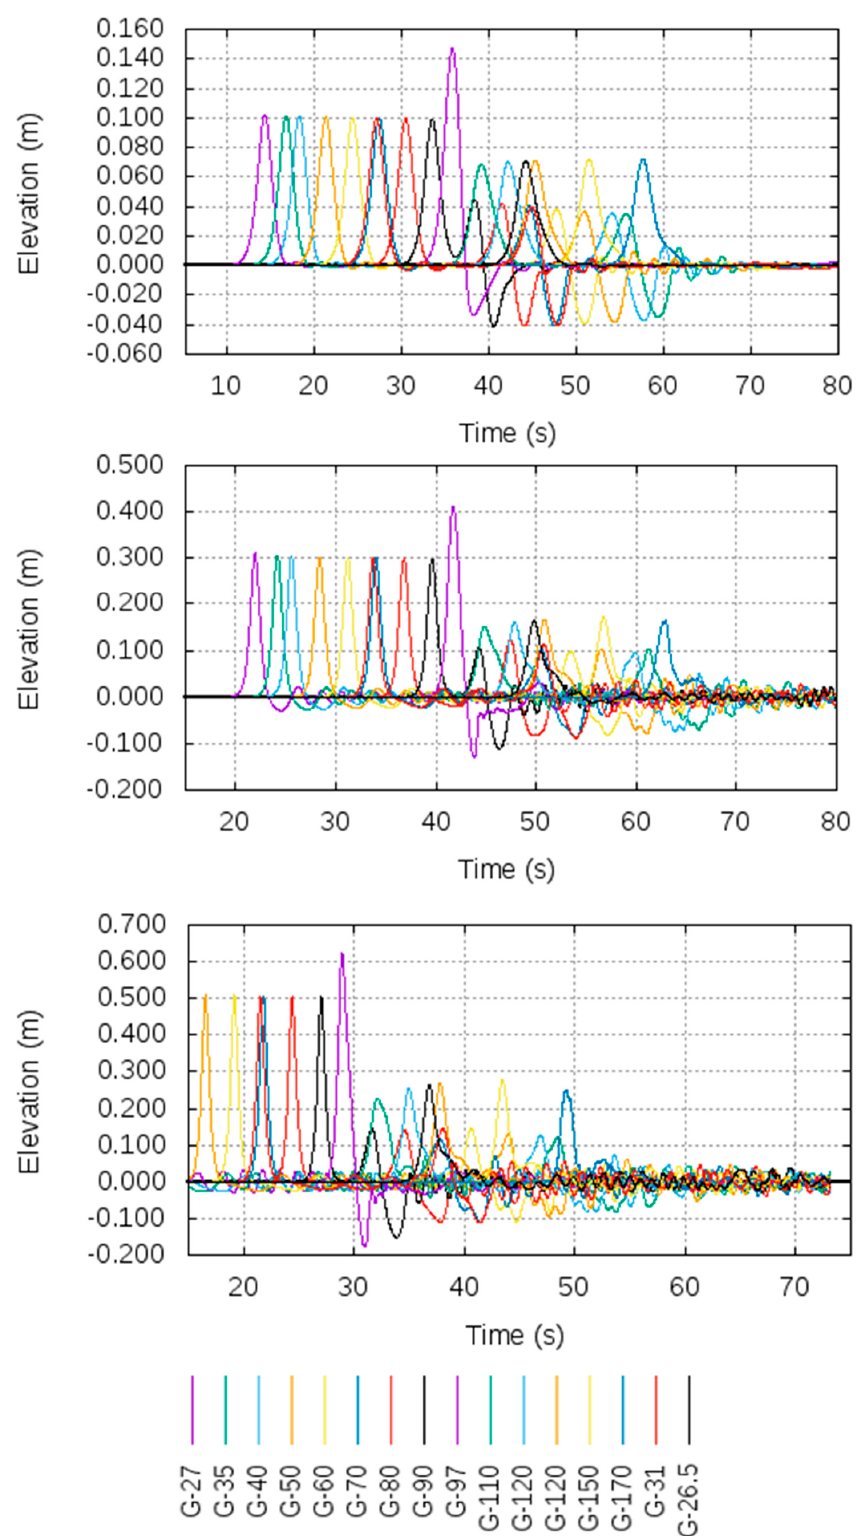
Figure 13. Free surface elevations measured by different wave gauges along the simulation domain a / h = 0.1, 0.3, and 0.5(from top to bottom, respectively; the legend is shown at the bottom) versus time t (s).